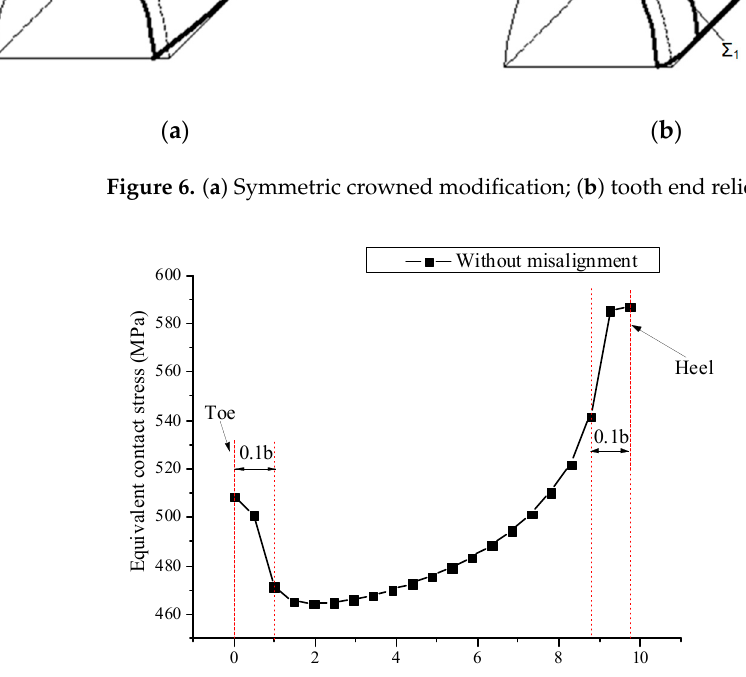
Figure 7. The distribution of contact stress along the direction of tooth width.